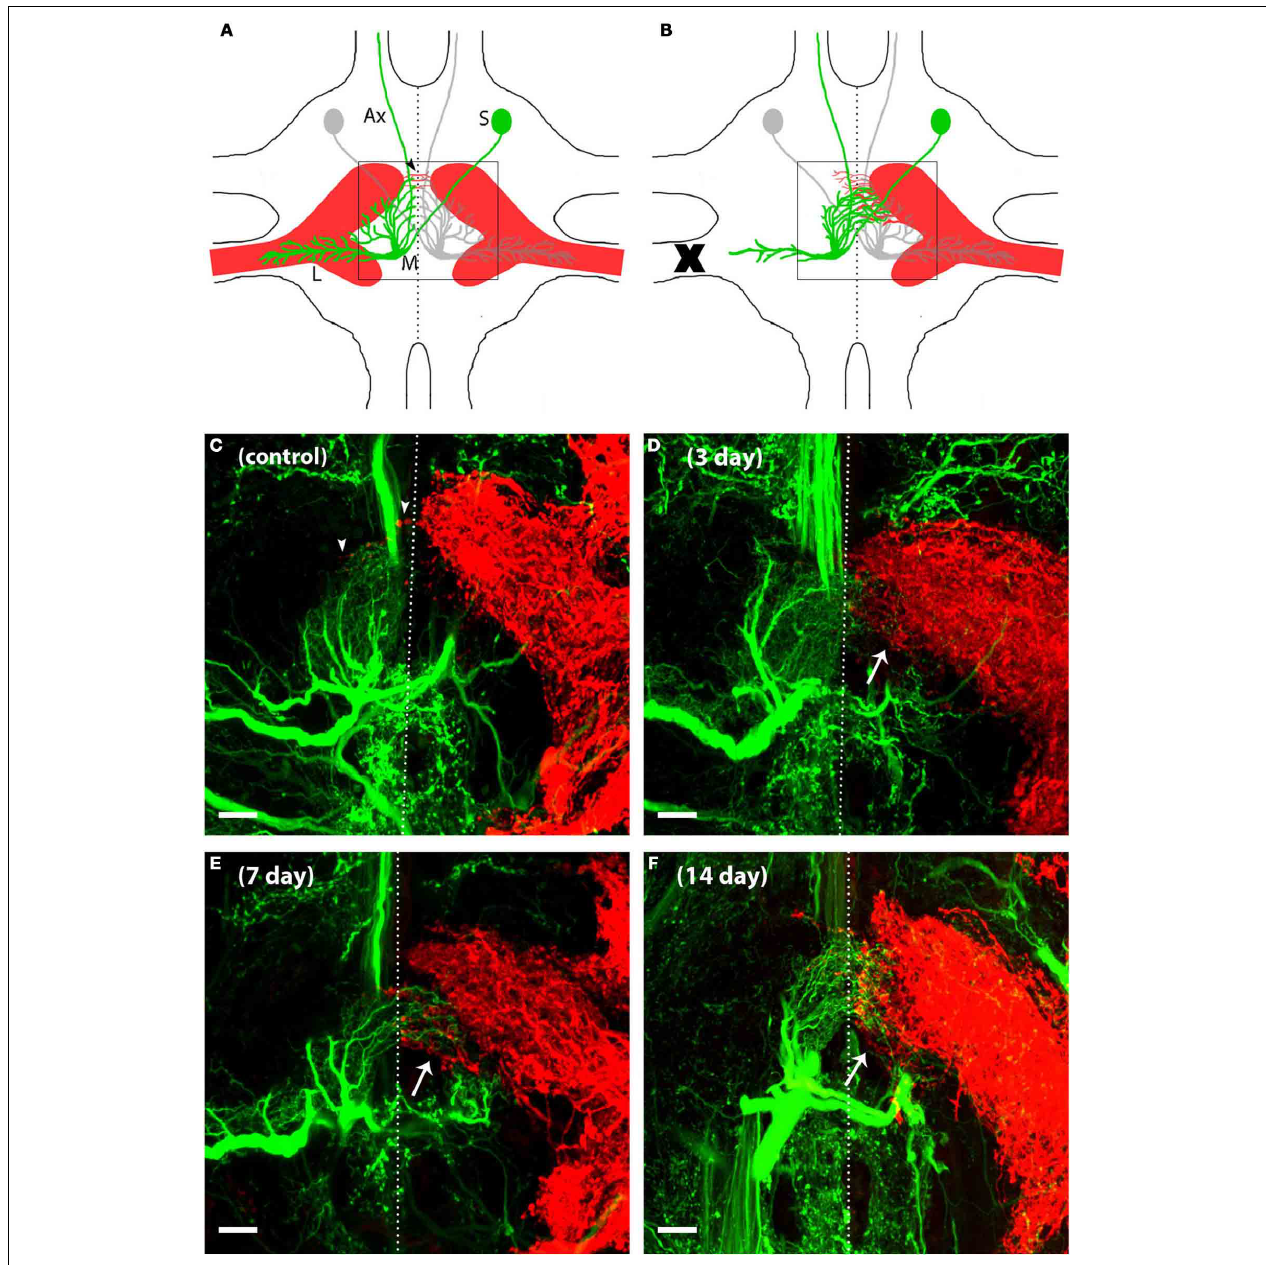
FIGURE 1 | AN dendrites and N5 axons reorganized their neuronal structure to grow toward one another after deafferentation in adult crickets. N5 (red) is composed in part of axons that carry auditory information from the tympanal organ on the cricket’s forelegs to the prothoracic ganglion where a variety of neurons, including AN-2 (green), receive the auditory information and send this information to the brain. (A) The schematic of a prothoracic ganglion in a control animal shows that AN-2 as well as N5 are bilaterally symmetric. The N5 axonal terminal structure resembles a “claw” shape. AN-2 dendrites are arranged in an L shape, with medial dendrites (M) synapsing with the upper portion of the ipsilateral N5 claw and lateral dendrites (L) extending into the N5 axonal track. Postsynaptic information is relayed to the brain via the AN-2 axon (Ax) that extends through the anterior end of the prothoracic ganglion. The AN-2 soma (S) is located on the contralateral side of the midline from its